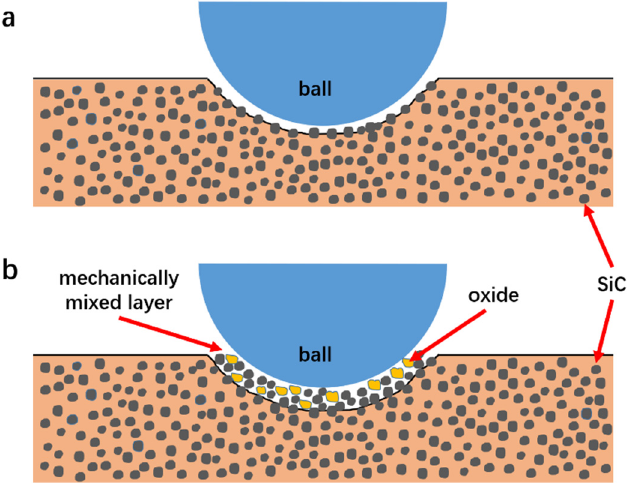
Figure 13. ( a ) The SiC particles started to loosen and detach from the matrix during sliding friction at high temperature; ( b ) SiC particles and oxides aggregated on the wear surface to form a mechanically mixed layer.